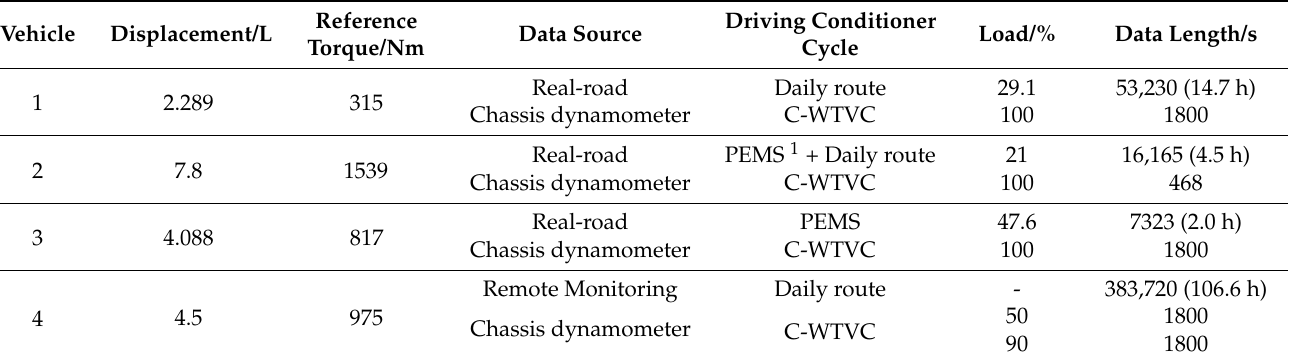
Table 3. Vehicle specifications and data sources.